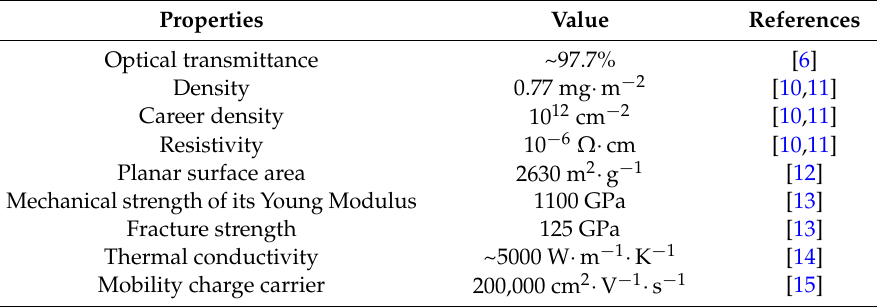
Table 1. General properties of grapheme.